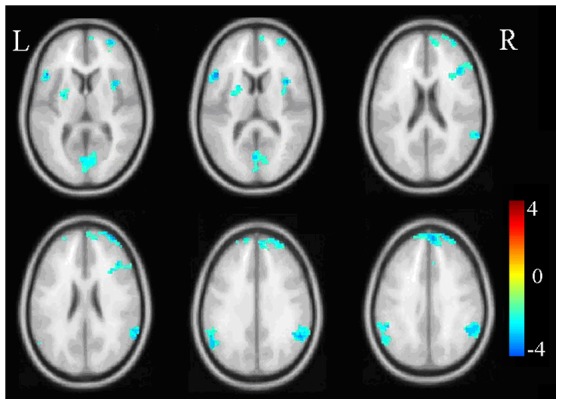
Group comparison in the negative-diminish condition.The cold color indicates decreased activation. The color bar indicates T-score. L:left, R:right.